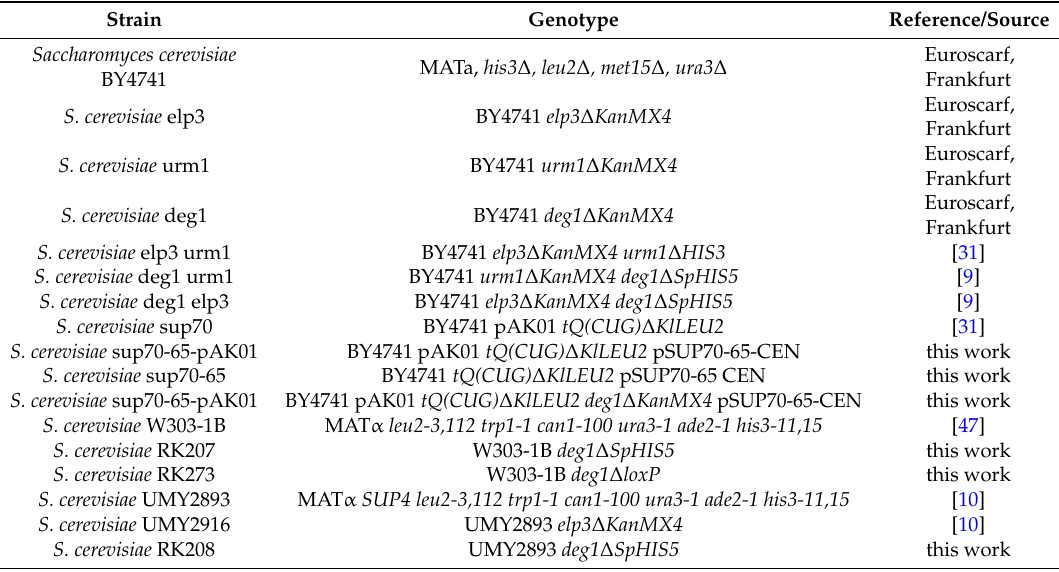
Table 1. Strains used in this